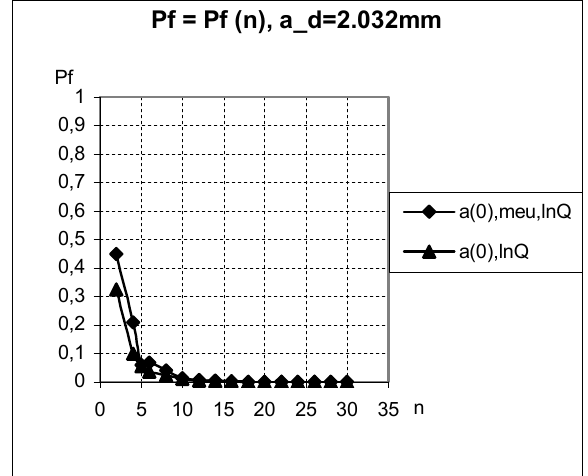
Fig 11. Failure probability in both the cases when m ≠ 2 and m = 2 for the non-corroded specimens with specified life = 400000